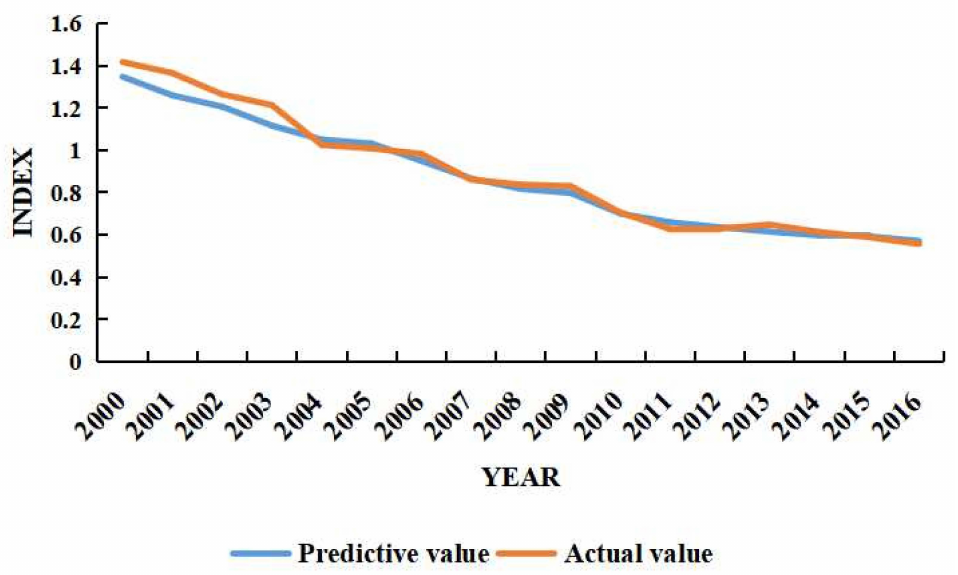
Figure 1. Results of the regression